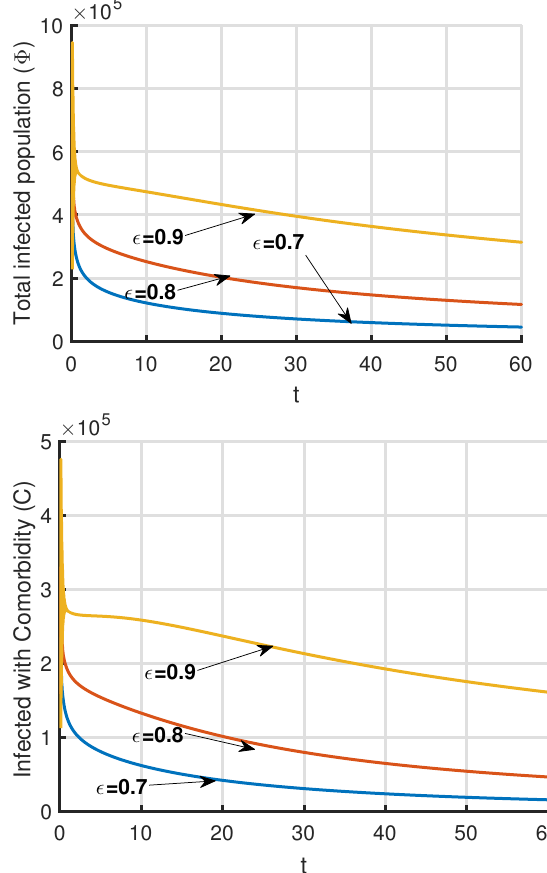
Figure 8. Time series of total infected population ( I + C ) and infected cases with co-morbidity when ε = 0.6,0.7,0.8,0.9.